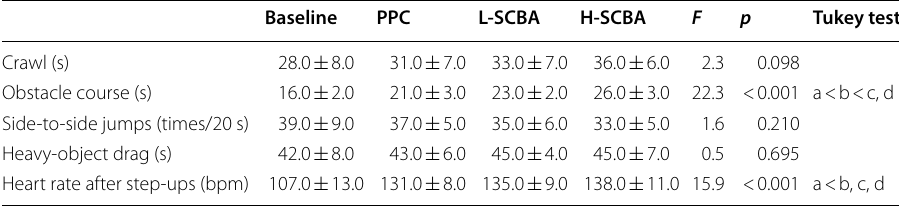
Results are presented as mean a: Baseline, b: PPC, c: L-SCBA, d: